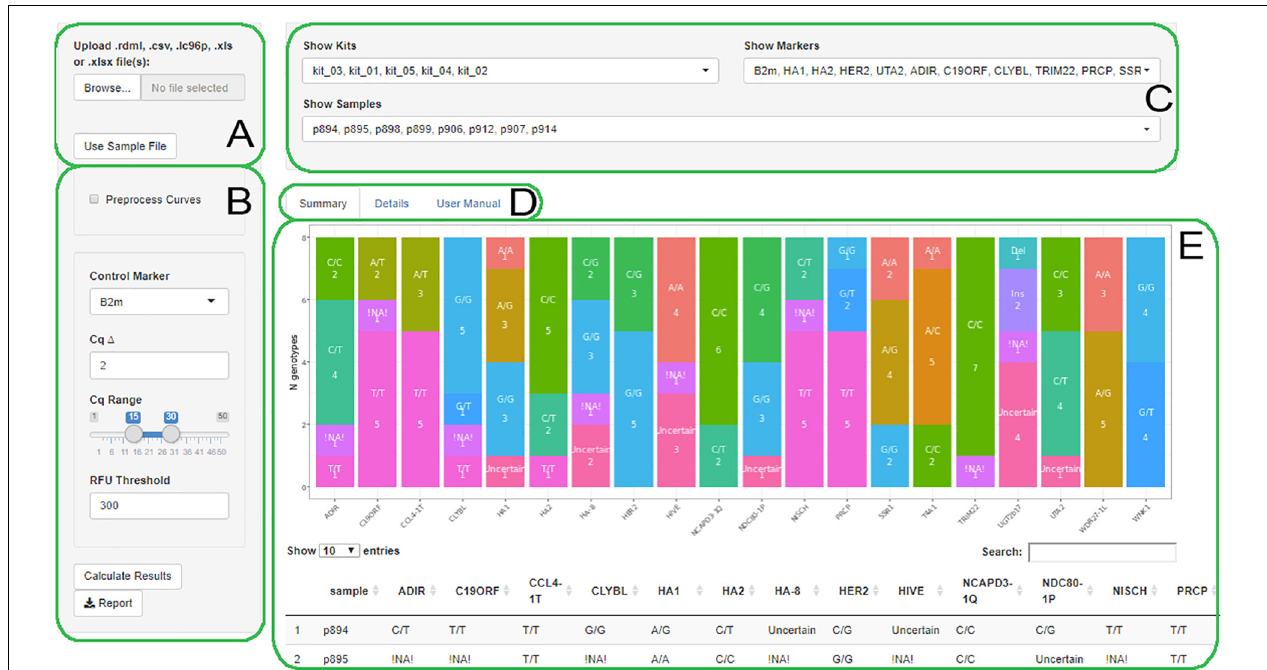
FIGURE 1 | The AScall web interface. (A) File selector; (B) Settings; (C) Filters; (D) Summary, Details or User manual tabs; (E) The Summary tab